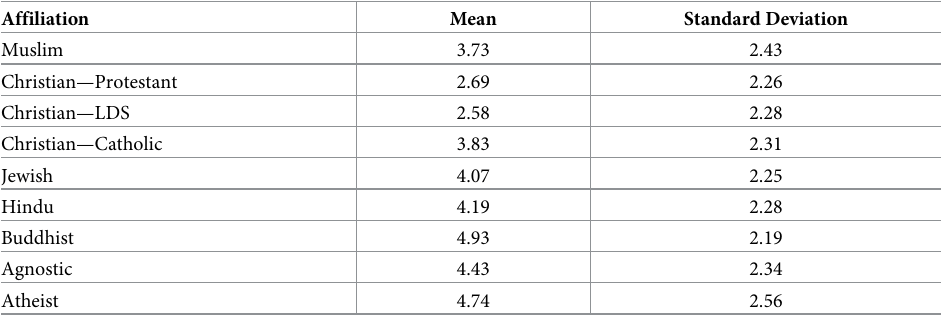
Table 4. The mean and standard deviation of students’ aggregated interest in taking an elective course on evolu- tion, interest in conducting research on evolution as an undergraduate, interest in a career involving research on evolution, and interest in becoming an evolutionary biologist.